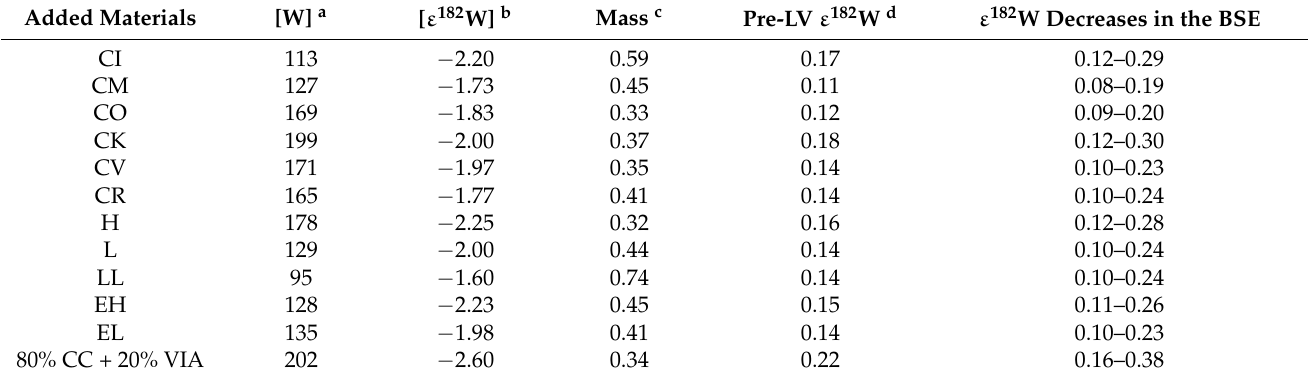
Table 4. Late veneer compositions and their effects on the ε 182 W of the BSE (following from